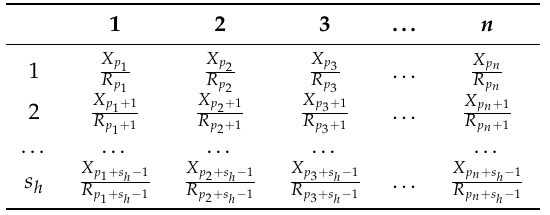
Table 1. Estimate of the weights of the values of the series on the rebuilt time series. In the columns each appearance of the discrete-interval moving seasonality (DIMS) is shown, and in the rows every time instant within the discrete